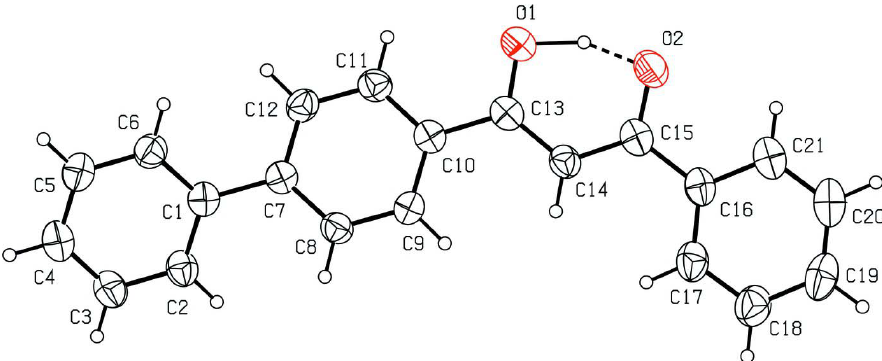
Figure 1 A view of the molecule 1 out of six independent molecules of the title compound, showing the atom-labeling scheme for non-hydrogen atoms. Displacement ellipsoids are drawn at the 50% probability level. It is difficult to show all molecules with atom labels. The dashed line indicates an intramolecular hydrogen